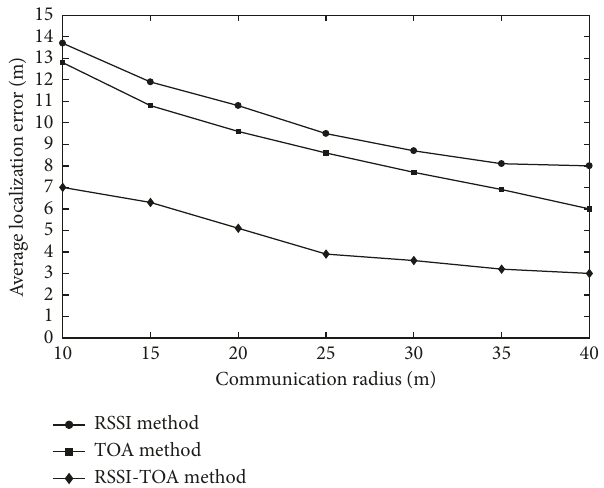
Figure 7: Relationship between communication radius and av- erage localization